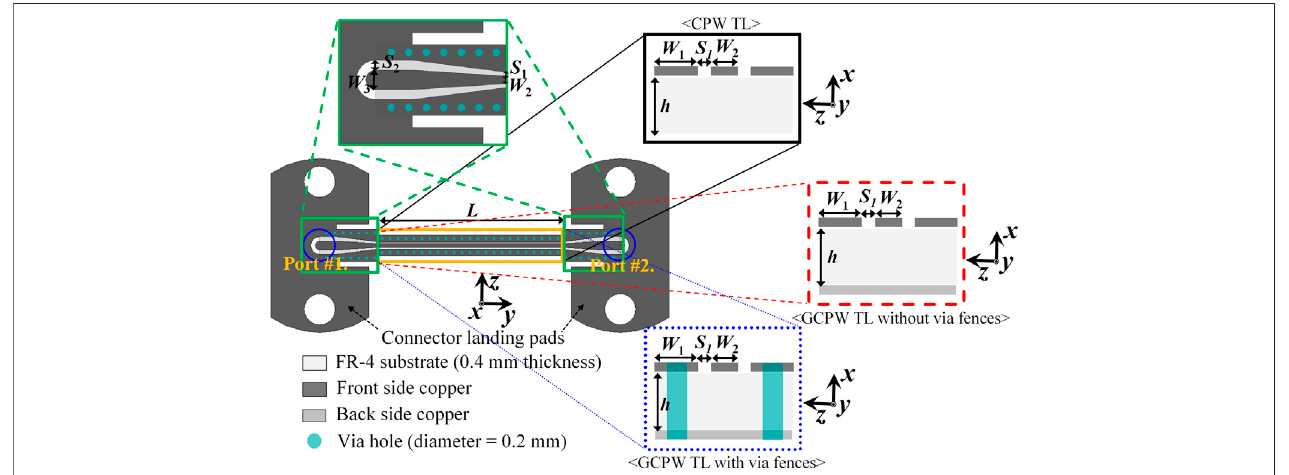
FIGURE 1 | Back-to-Back Con fi gurations of three types of feeding networks with symmetric connector landing pads ( h (cid:2) 0.4 mm, W 1 (cid:2) 0.4 mm, W 2 (cid:2) 0.2 mm, W